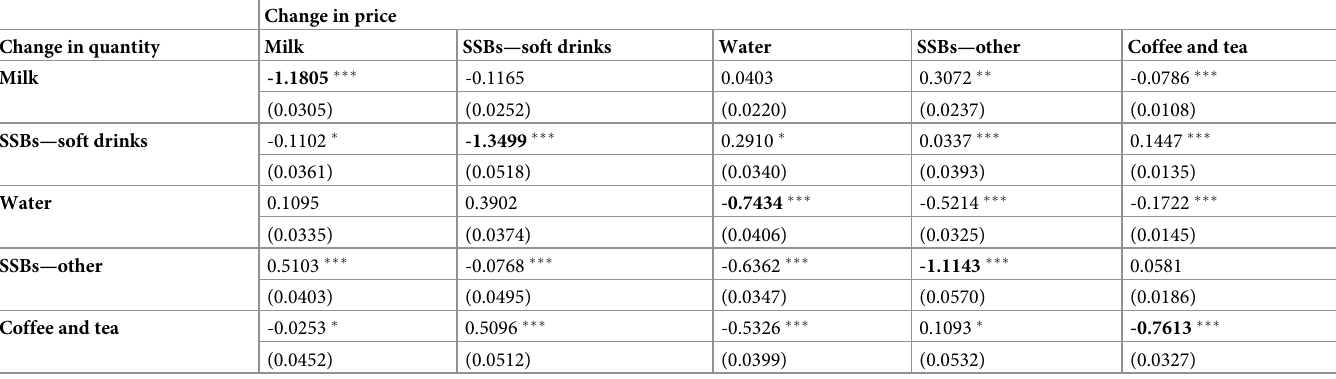
Table 3. Uncompensated price elasticities: Whole sample.